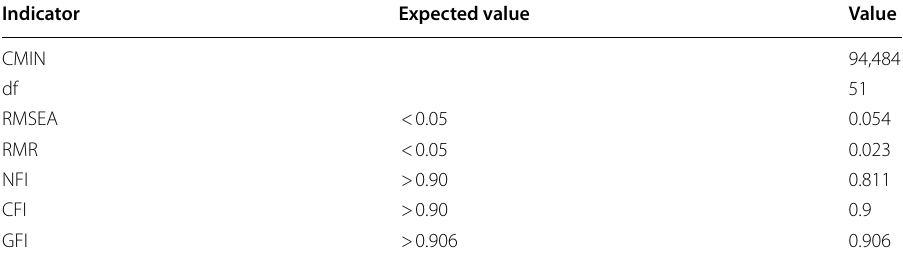
Table 5 Indicators for measuring the model’s adequacy